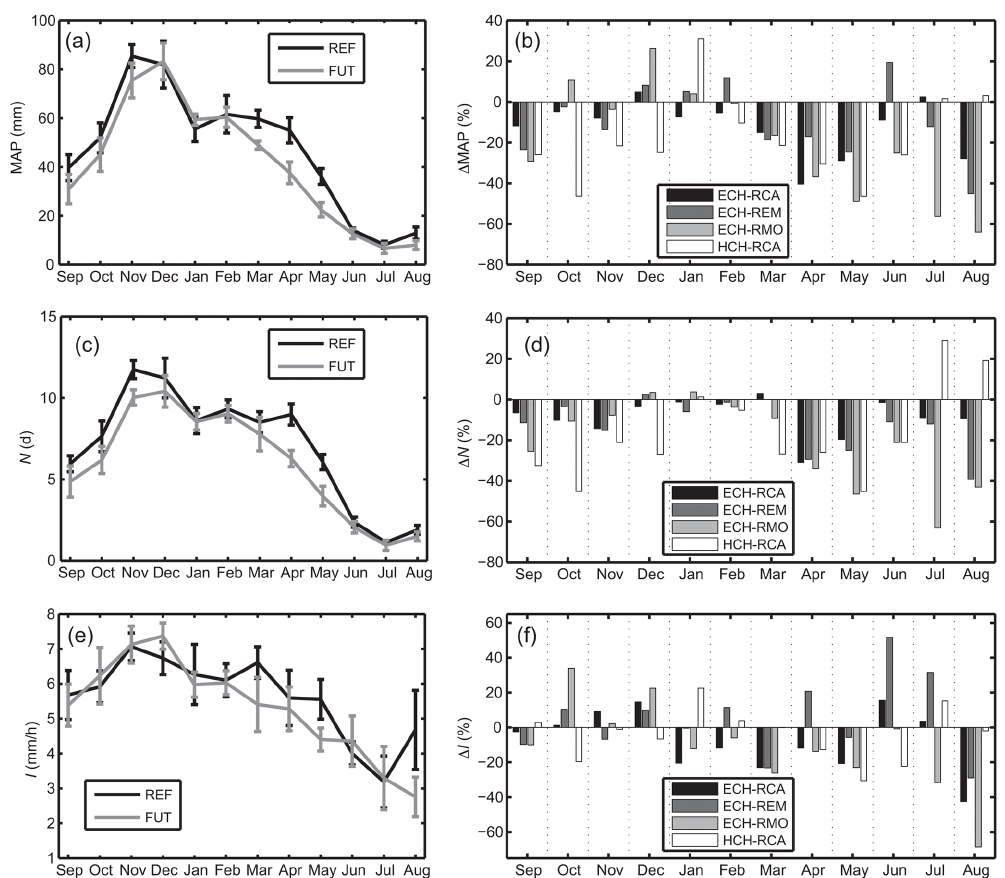
Figure 4. (a) Mean monthly MAP in the RMB in REF (black) and FUT (gray). Bars are mean ± standard deviation across the CMs. (b) Rel- ative change between FUT and REF periods in mean monthly MAP ( (cid:49) MAP). (c) and (d) same as (a) and (b) , but for the mean monthly N . (e) and (f) same as (a) and (b) , but for the mean monthly I